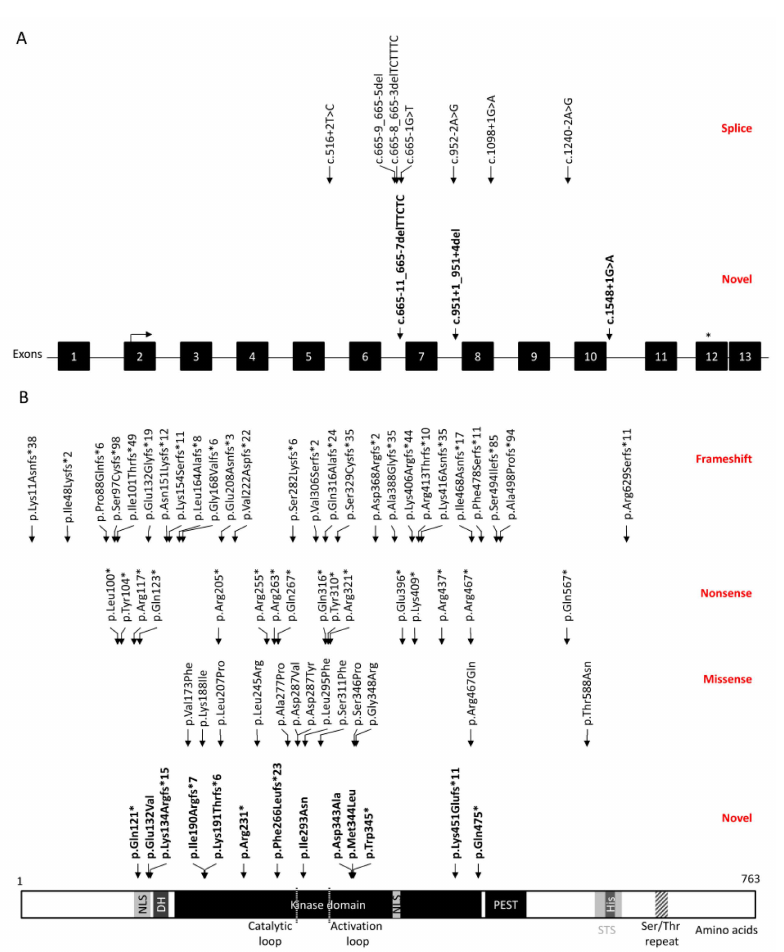
Figure 1. Mutational spectrum of DYRK1A -related intellectual disability syndrome. ( A ) Splice site variants are depicted across the 13 exons of DYRK1A (NM_001396.5). Novel splice site variants are in bold. ( B ) Amino acid change of frameshift, nonsense, missense and novel variants are mapped across the DYRK1A protein (NP_001387.2, Uniprot Q13627). Nuclear localization signals (NLS) between amino acid position 117–134 and position 386–394 are marked in grey; DYRK homology (DH) box [amino acid 137–153] is in grey; protein kinase domain [amino acid 159–479] is in black; catalytic loop [amino acid 285–287] and activation loop [amino acid 319–321] are depicted in hatched black box; PEST domain [amino acid 482–525] is in black; speckle-targeting signal (STS) [amino acid 596–624] is in grey; histidine repeat (His) [amino acid 607–619] in dark grey; and a Serine/Threonine (Ser/Thr) repeat [amino acid 659–672] is in hatched black box [3,52]. The in-frame deletion, c.914_919del p.(Ile305_Asp307delinsAsn), is not reported in this